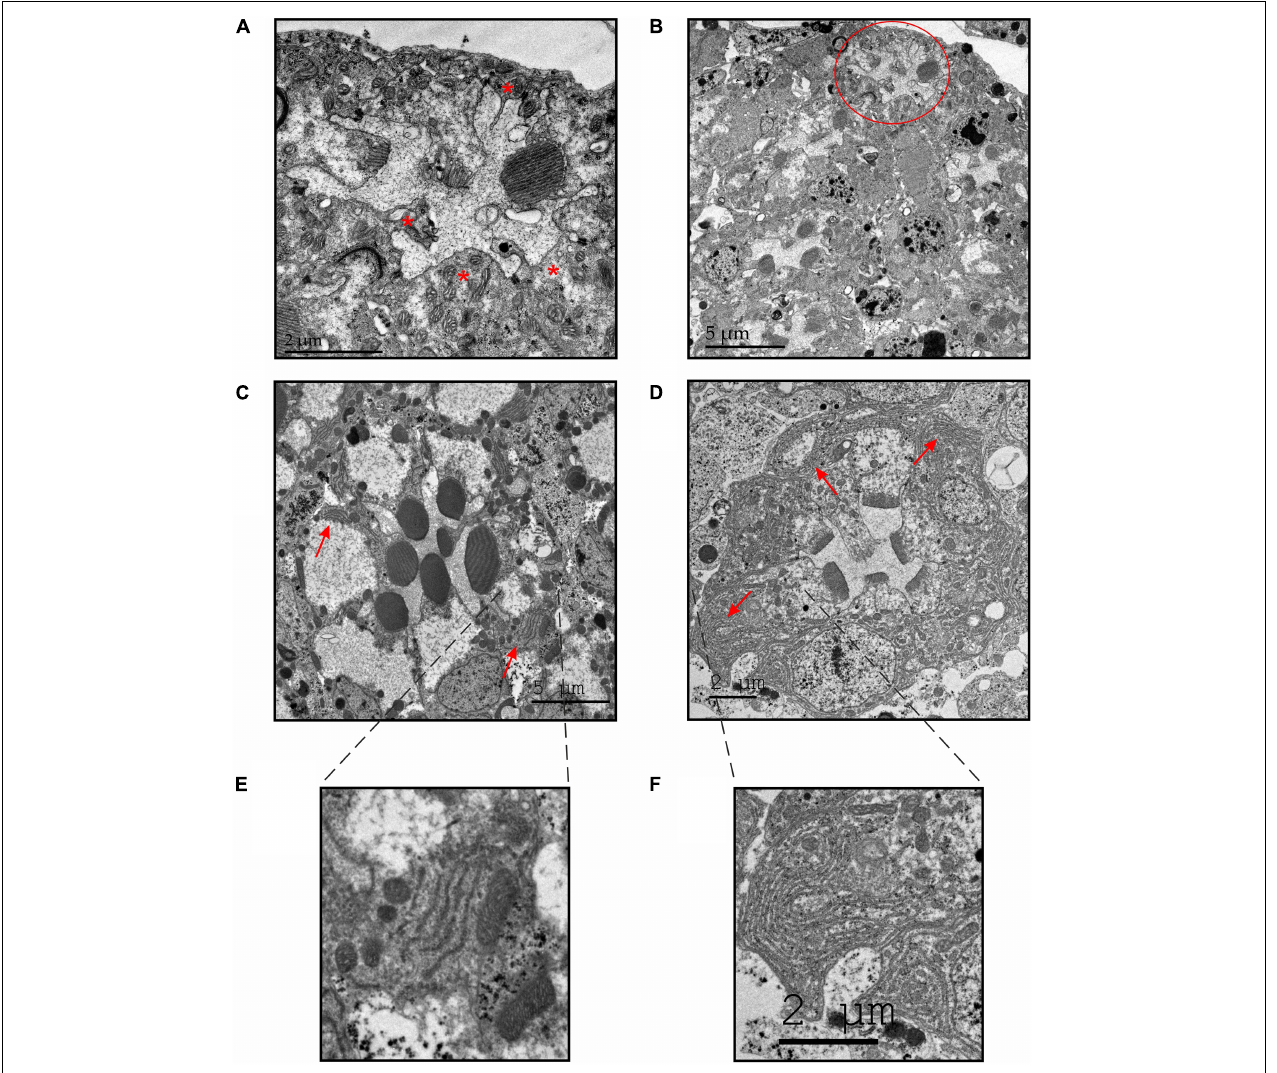
FIGURE 6 | TEM sections of GMR-DHDDS-RNAi flies revealed an enhanced degeneration with increasing age and an abnormally large accumulation of ER membranes in the affected retinae. (A,B) Representative thin TEM cross retinal sections at a ∼ 55 µ m depth (from the corneal surface) showing an ultrastructure of a 12-days-old GMR-DHDDS-RNAi fly at a high ( × 2500, A ) and low ( × 800, B ) magnification. Missing rhabdomeres are marked with asterisks in (A) . The ommatidium shown in (A) is marked with a red circle in (B) . (C,D) Representative thin TEM cross retinal sections at a ∼ 55 µ m depth (from the corneal surface) of dark-raised newly eclosed control ( w 1118 ) flies (C) and GMR-DHDDS-RNAi flies (D) at a high magnification. The red arrows show the normal appearance of ER membranes in (C) and the abnormal accumulation of ER membranes in (D) . (E) An enlarged image of the indicated area in (C) showing a normal manifestation of ER membranes in the control ( w 1118 ) ommatidium. (F) An enlarged image of the indicated area in (D) showing an abnormal accumulation of ER membranes in the affected retinae of GMR-DHDDS-RNAi